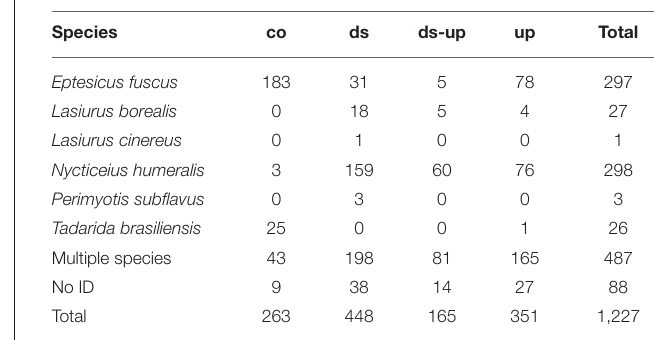
FIGURE 2 | Common types of social call bouts, based on the types of individual social calls contained. Call type abbreviations: co, complex; ds,